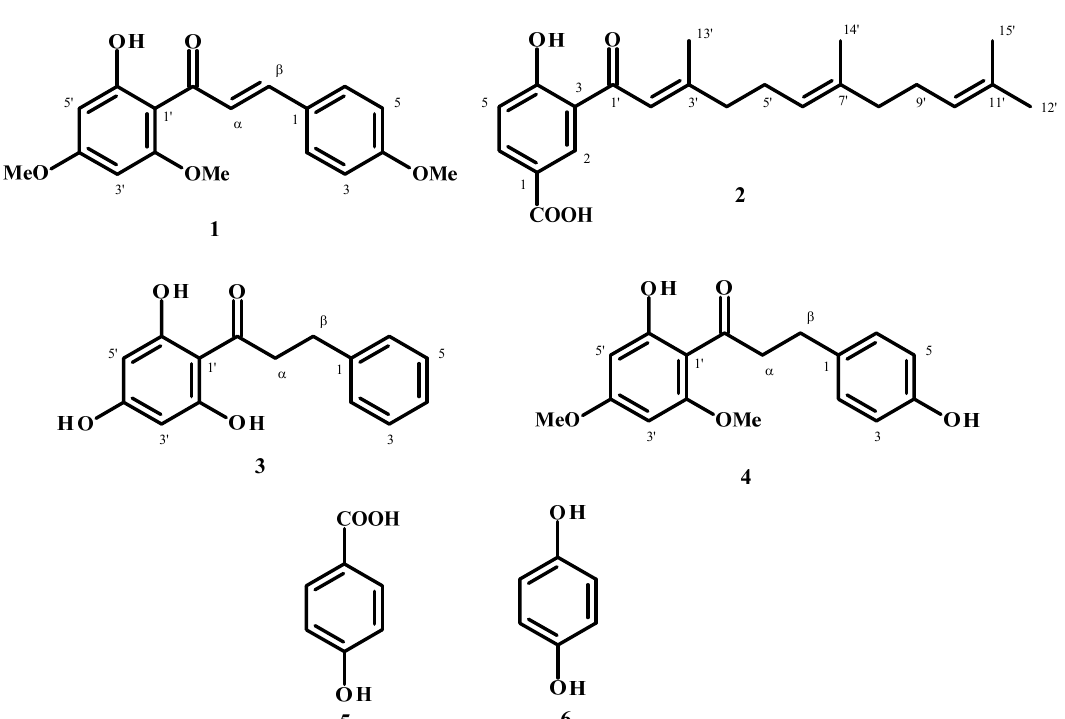
Figure 1. Chemical structures of the compounds assessed in this